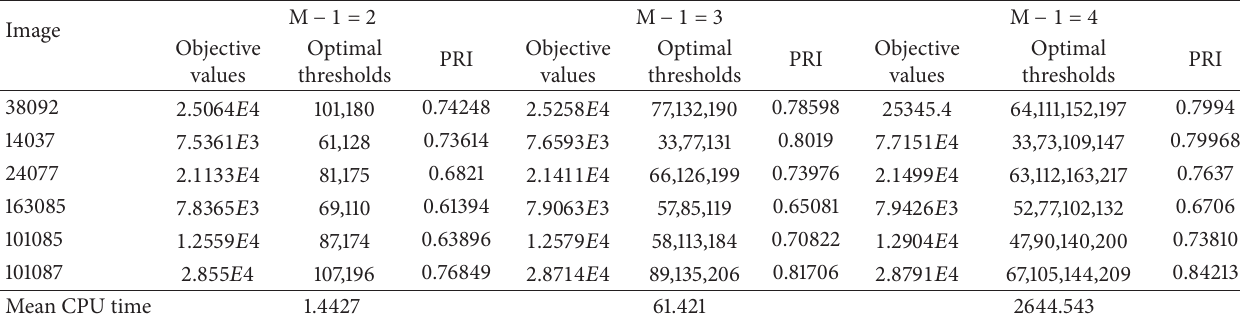
Table 8: The mean CPU time of the compared population-based methods on Otsu algorithm.